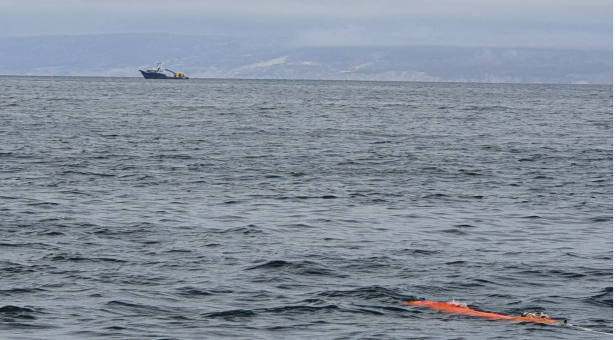
Figure 16. Glider emerging from the depths of the sea in the Bay of Todos Santos in Ensenada, Baja California,